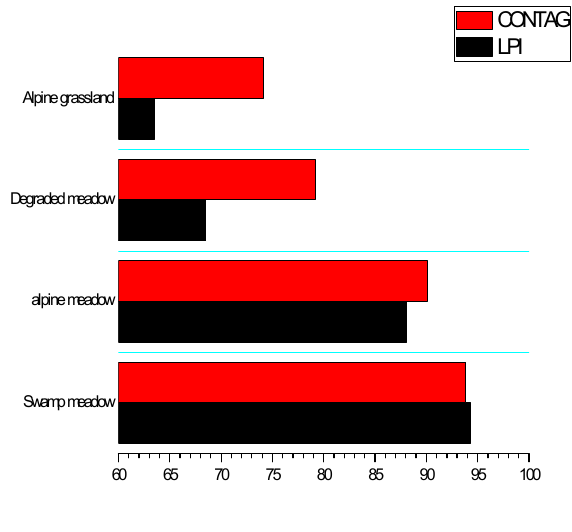
Figure 5. CONTAG and LPI of four grassland patch types